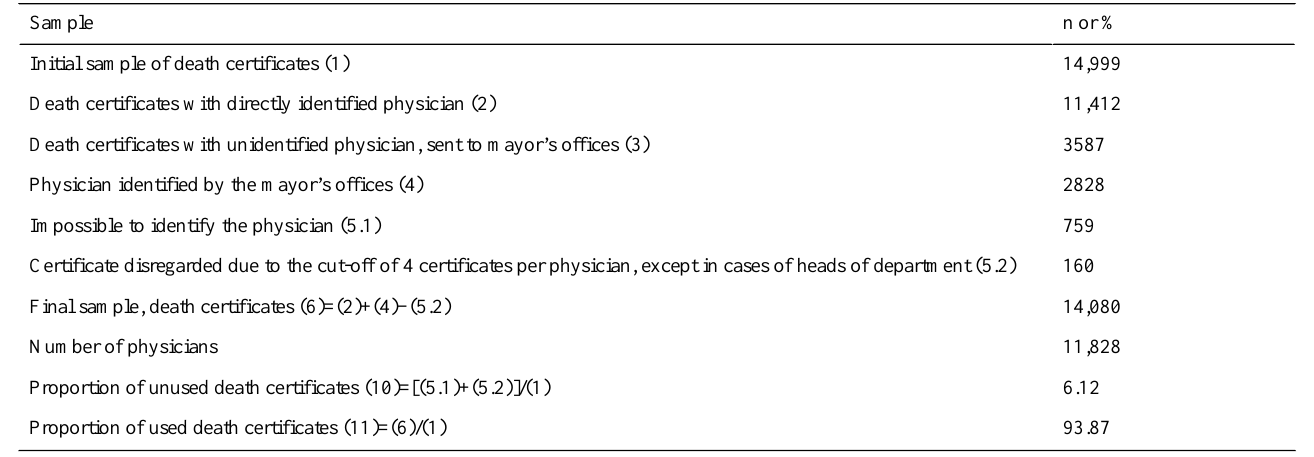
Table 1. Identification of physicians/death certificates. a